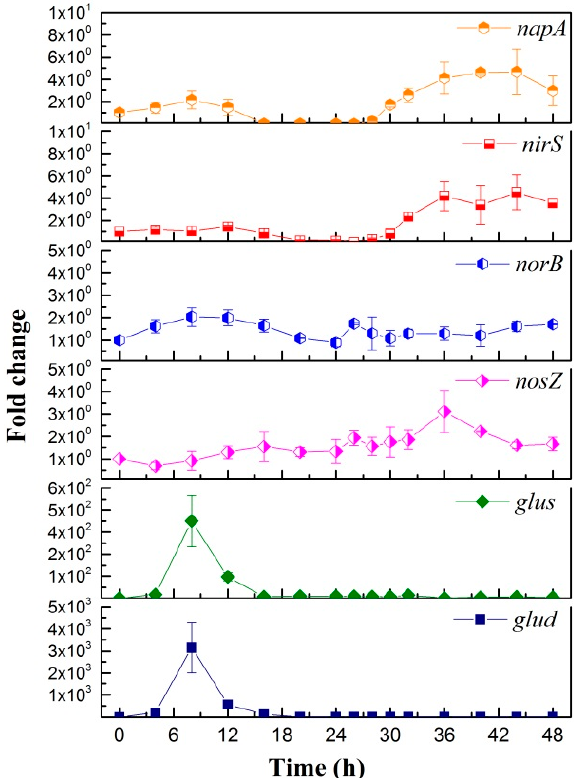
Figure 4. Denitrifying and glutamic acid related genes expression under heterotrophic ammonium removal of the strain RAD-17 during 48 h of incubation.